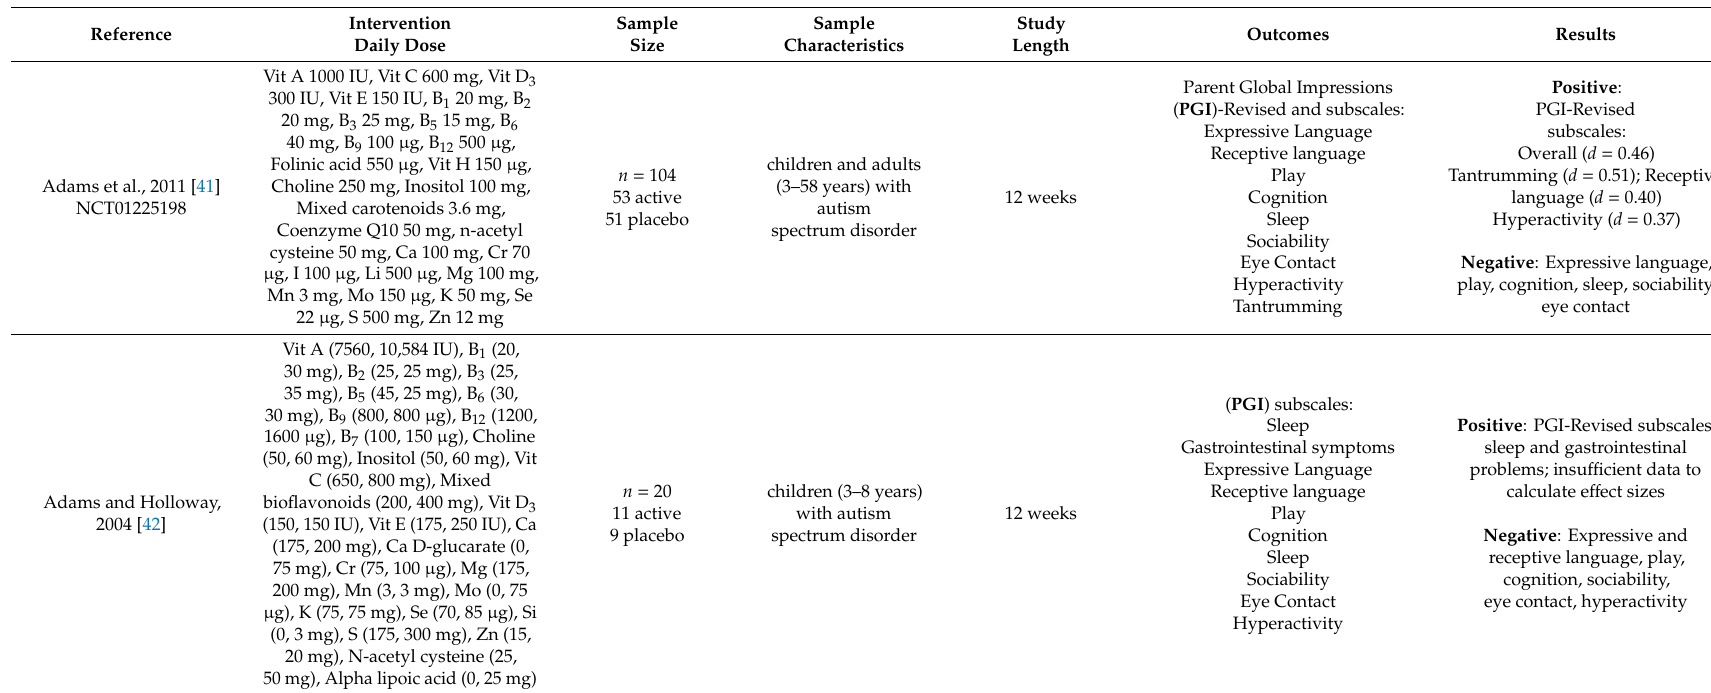
Table 7. Autism studies ( n =